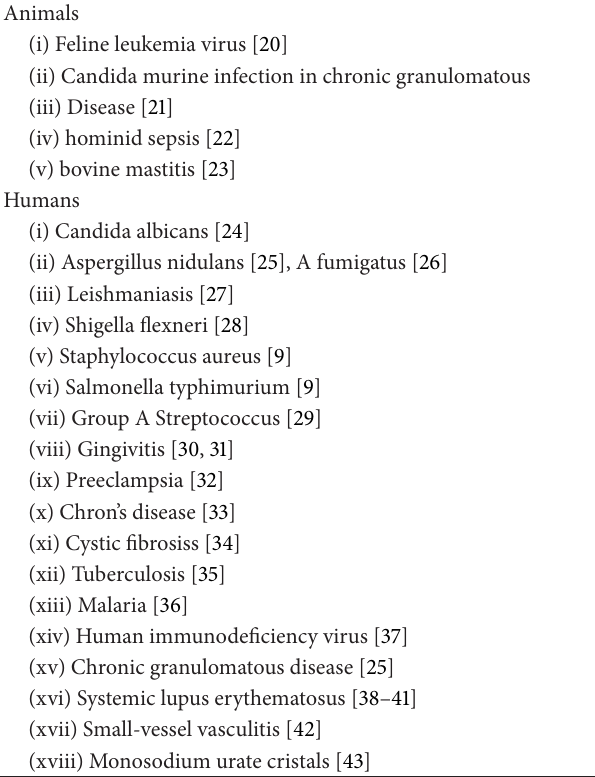
Table 3: NETosis